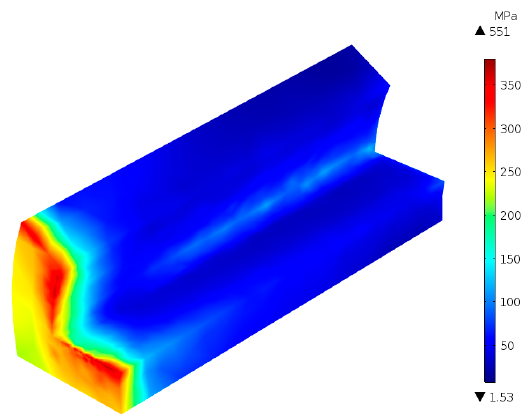
Figure 22. The von-Mises stress distribution in the iron when the temperature inside the winding is 106 °C.